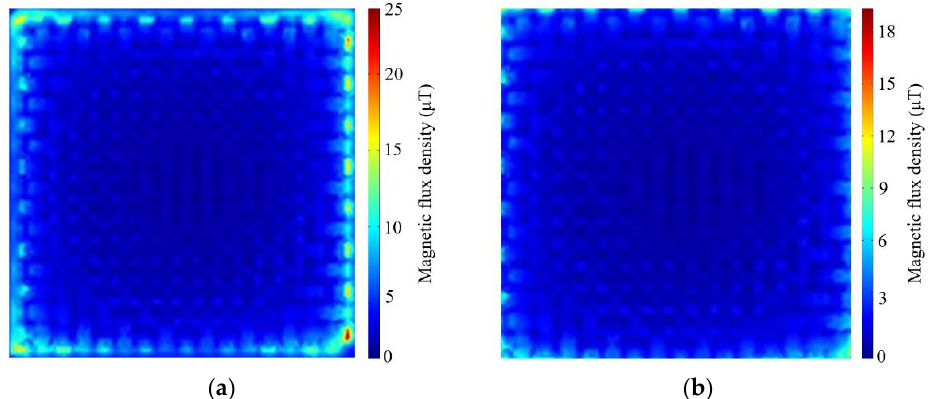
Figure 6. Simulation results of magnetic field distribution in x – z plane of composite material shield- ing: ( a ) transmitting side and ( b ) receiving side.